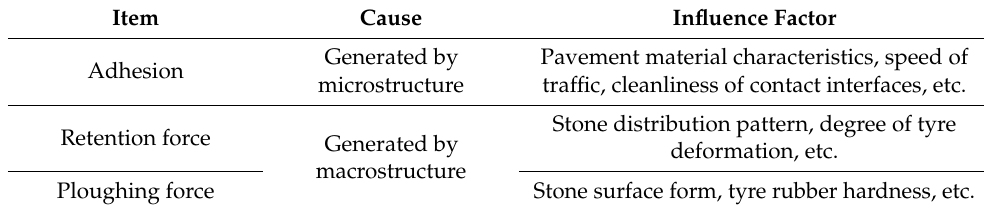
Figure 1. Mechanisms of anti-slip performance of asphalt pavements. Table 1. Mechanisms of anti-slip performance of asphalt pavements.